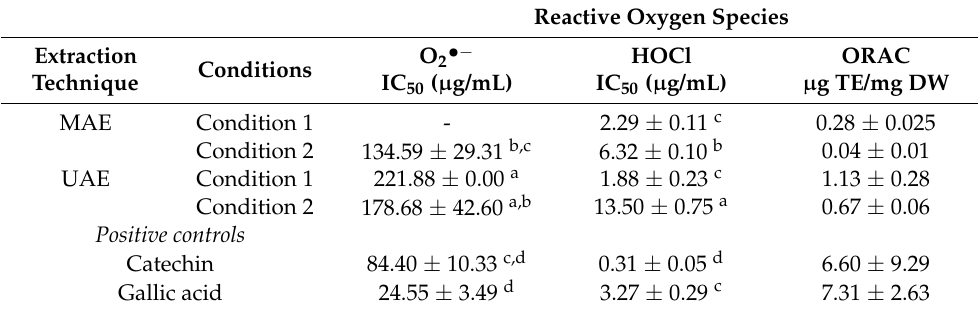
Table 2. Reactive oxygen species scavenging capacity (evaluated by O2 •− , HOCl and ORAC assays) of C. pepo extracts prepared by microwave-assisted extraction and ultrasound-assisted extraction (MAE and UAE, respectively). Values are expressed as mean ± standard deviation ( n = 3). Reactive Oxygen Species Extraction Technique